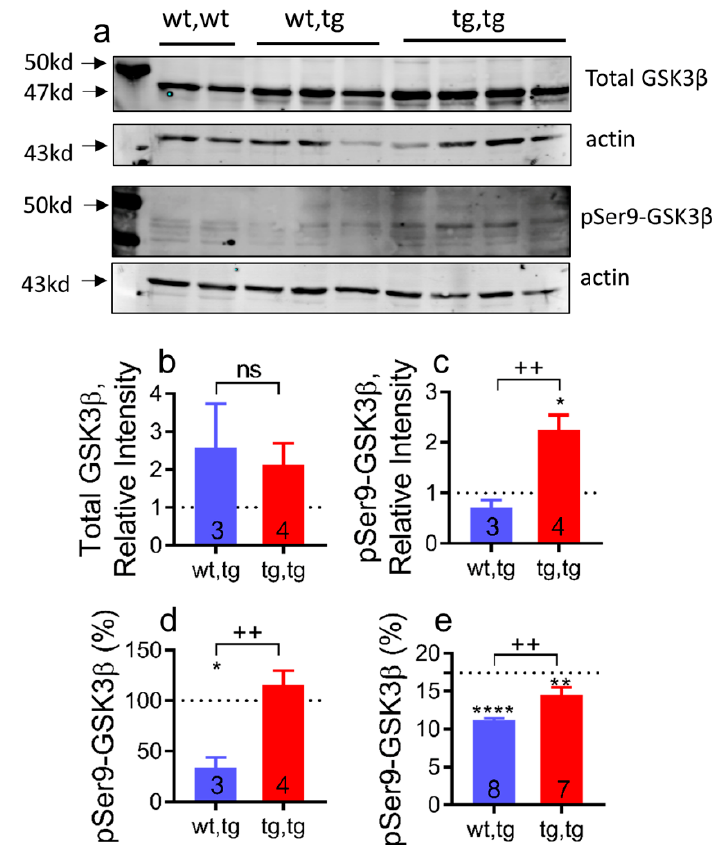
Figure 7. Corin-Tg(i) overexpression modulates pSer9-GSK3 β levels in female DCM mice. ( a ) Western blot analysis of cytosol fraction of heart tissue extracts, with antibodies directed against total GSK3 β and pSer9-GSK3 β under reducing conditions; each lane represents an individual mouse sample. Row